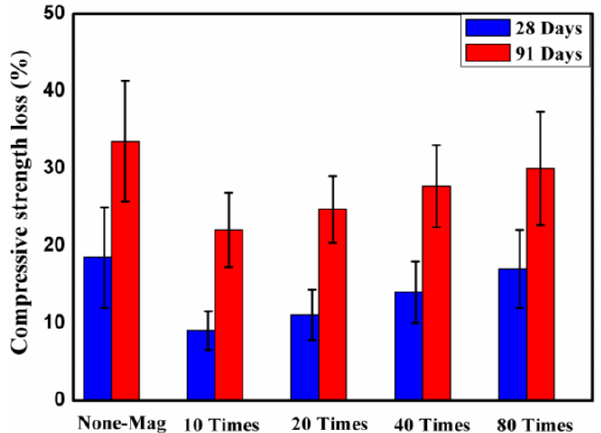
Figure 9. Degradation and percentage changes in the compressive strength of concrete block specimens exposed to 5% by weight of H 2 SO 4 solution after 28 and 91 days of exposure.